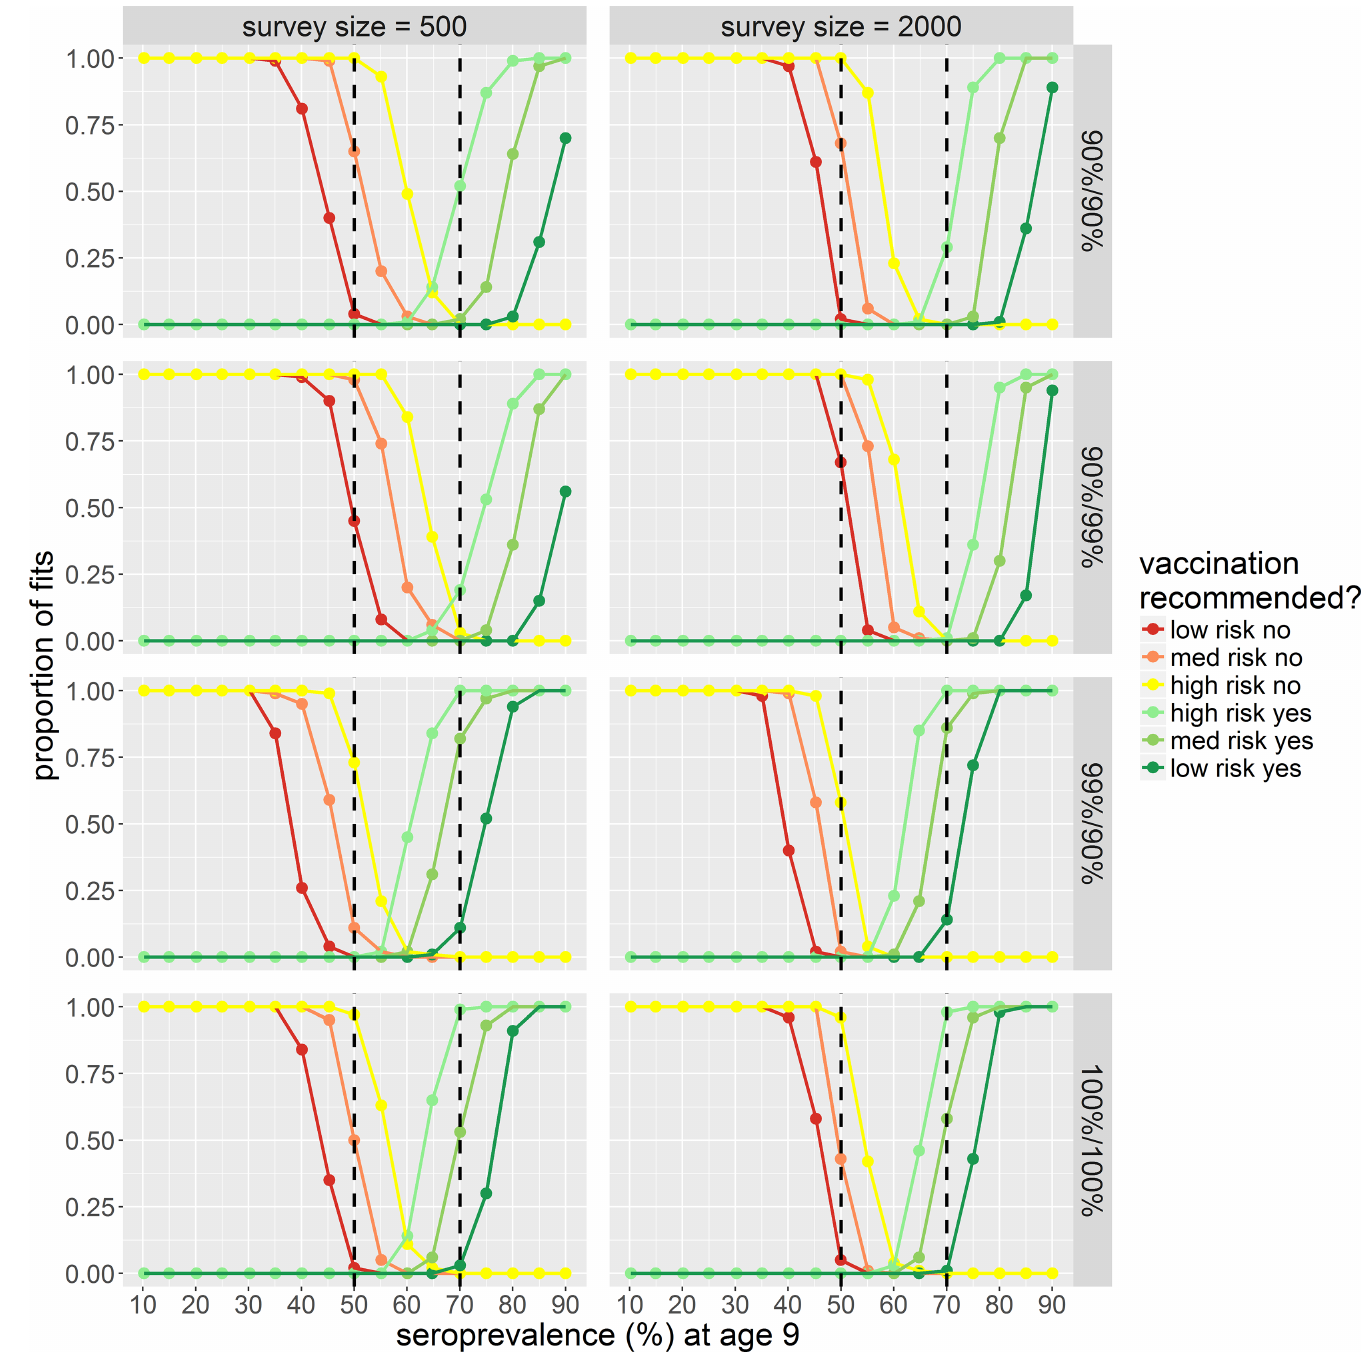
Fig 5. Proportion of model fits (of 100) which result in the correct vaccination recommendation for a range of transmission settings defined by seroprevalence in 9 year olds (low: P9 = 10%, to high: P9 = 90%). Rows show results for different test sensitivities and specificities (Se%/Sp%). Columns for survey sizes of 500 and 2000, estimated from a fixed age range of 0–20 year olds. The black dashed lines represent seroprevalence thresholds of 50% and 70%. Red = vaccination is not recommended, green = vaccination is recommended. Low risk no = upper 95% CrI < 50%, med risk no = central estimate < 50%, high risk no = upper 95% CrI < 50%, high risk yes = upper 95% CrI above 70%, med risk yes = central estimate > 70%, low risk yes = lower 95% CrI > 70%. CrI = credible interval.